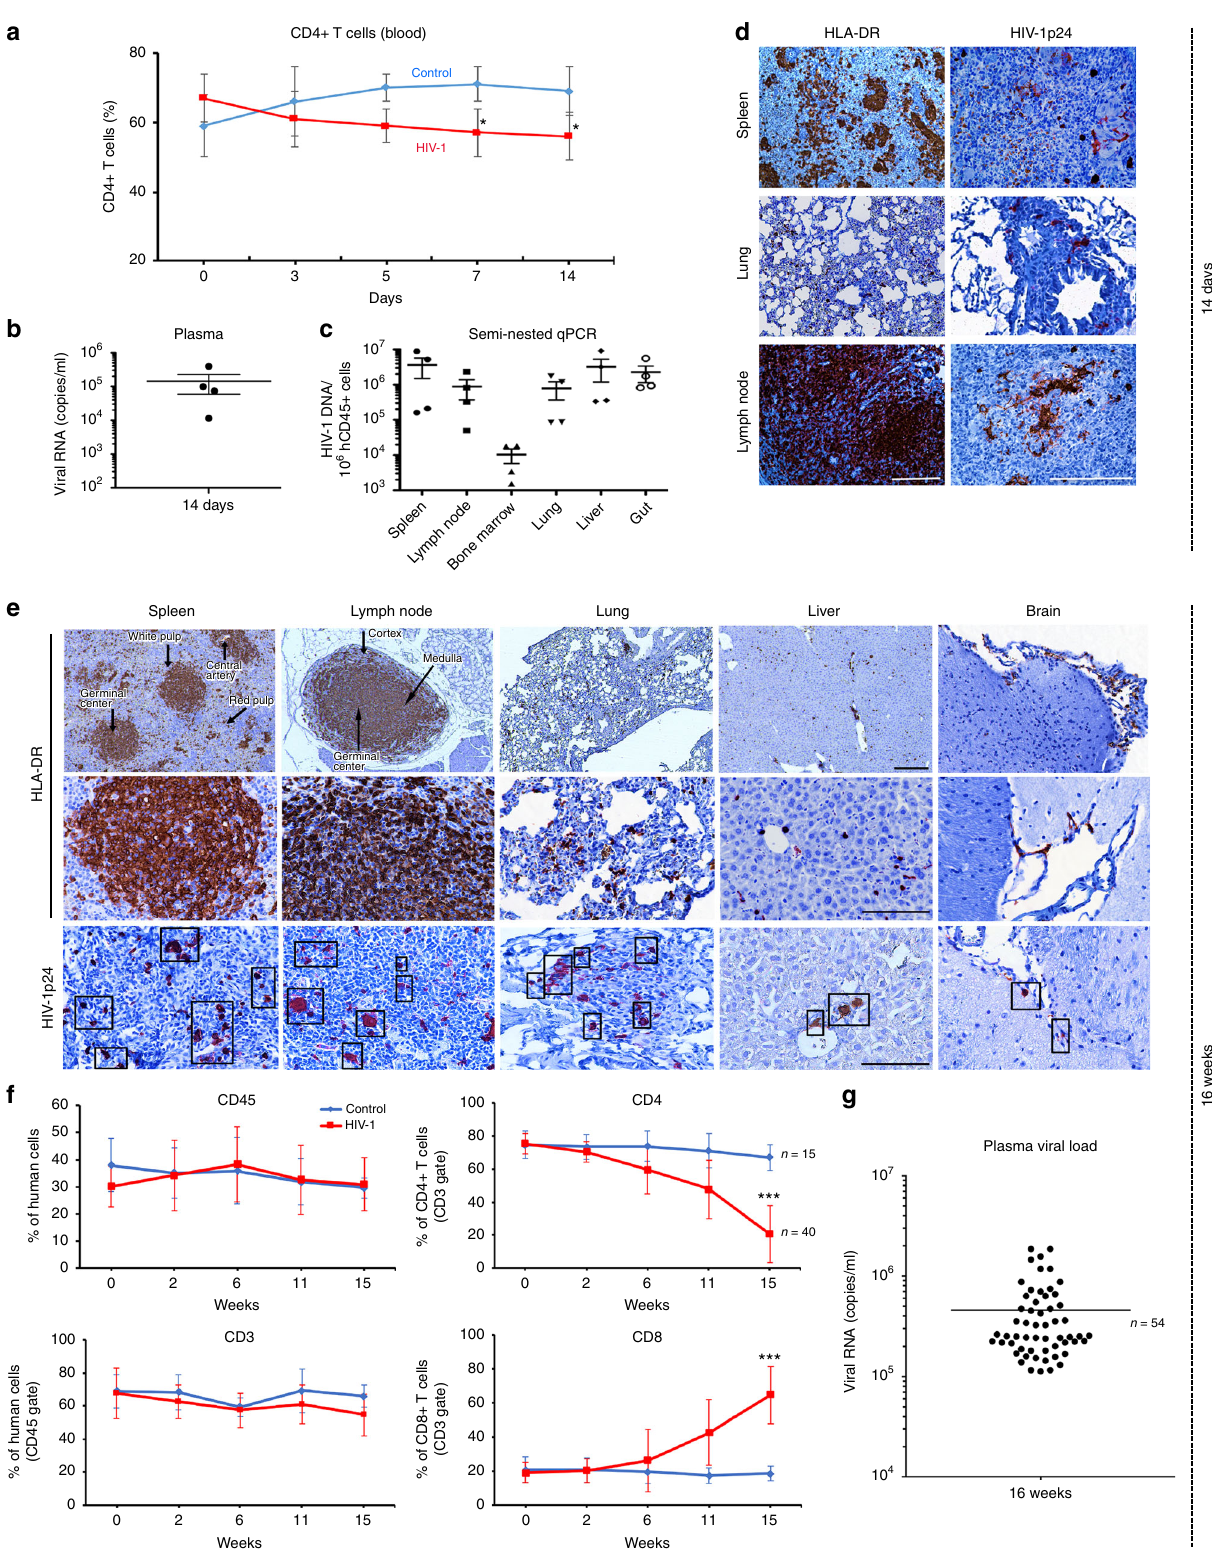
control over viral replication, and the short tail of drug removal from blood and tissue af fi rmed that any lack of viral rebound would accurately re fl ect residual HIV-1 growth rather than any residual antiretroviral drug present as part of the long-acting